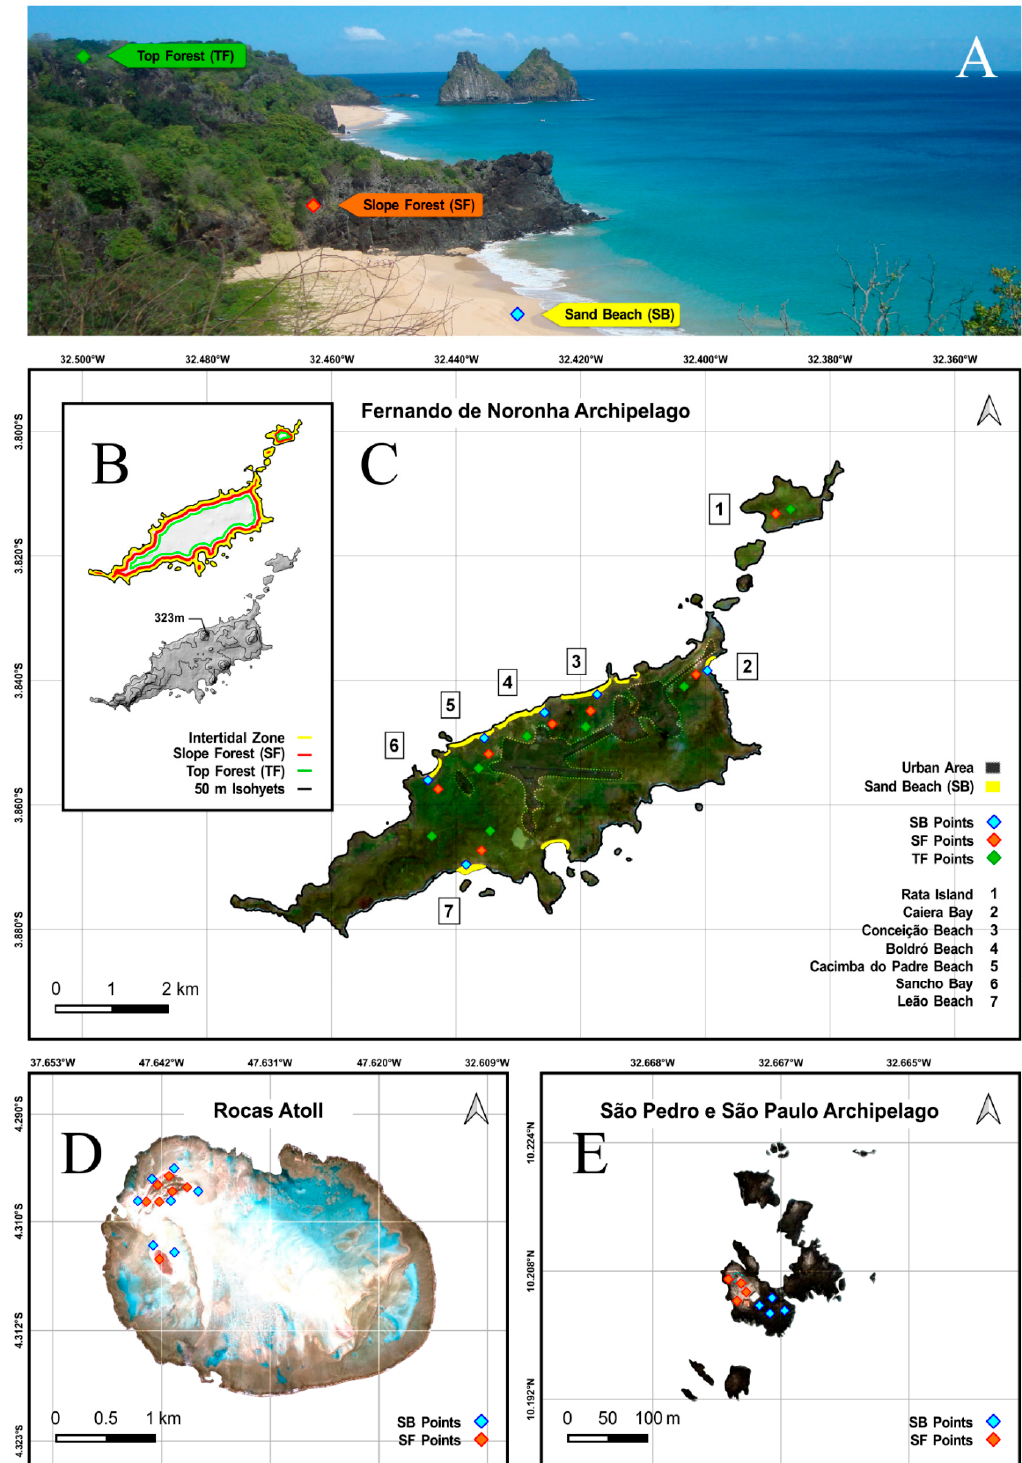
Figure 2. Maps of distribution sites sampled: ( A ), example of sampled environments; ( B ), map with delimitation of areas and elevation map; ( C ), Fernando de Noronha sites; ( D ), Rocas Atoll sites; ( E ), S ã o Pedro e S ã o Paulo